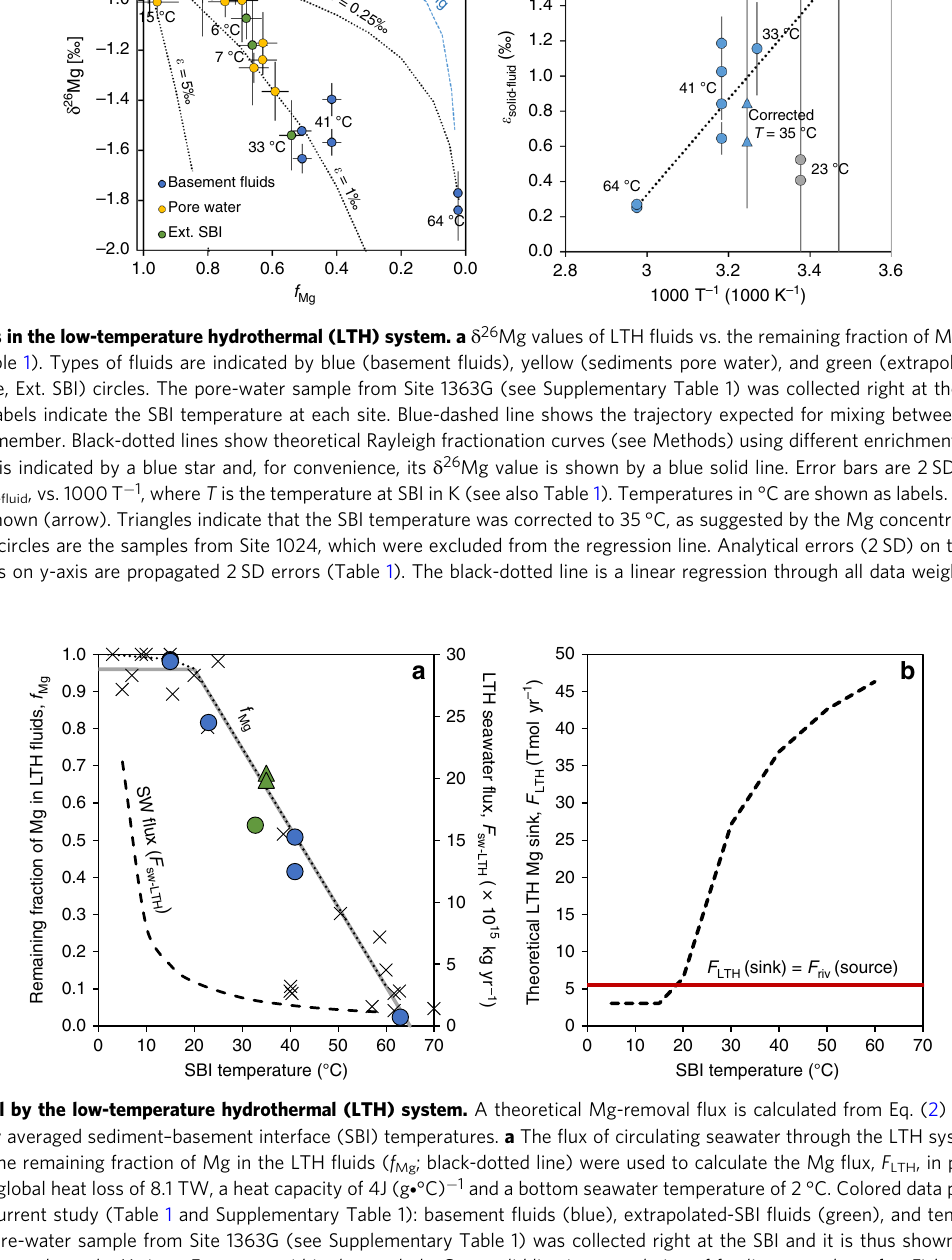
~10 °C higher than the modern temperature, as suggested by Gillis and Coogan 48 for the Cretaceous, would deplete the entire seawater Mg reservoir within a few Myr. Evidence from fl uid inclusions in halite rule this out e.g., 49,50 , requiring an ef fi cient negative feedback mechanism that is still unknown.